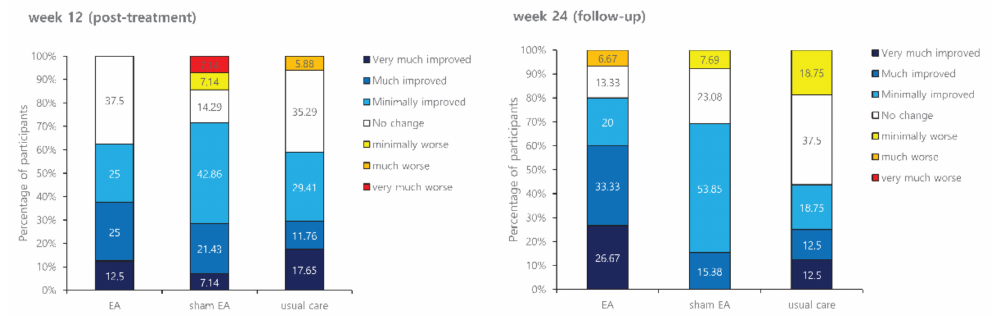
Figure 4. Effects of treatment on Patient Global Impression of Change